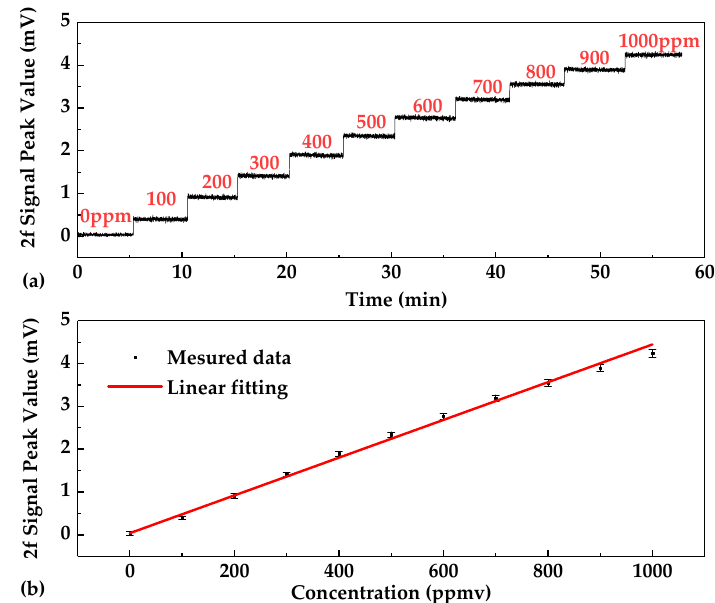
Figure 11. ( a ) Measured 2 f signal amplitude versus calibration time t for different C 2 H 2 concentration levels ranging from 0 to 1000 ppmv. ( b ) Experimental data dots and fitting curve of C 2 H 2 concentration versus the 2 f signal amplitude.